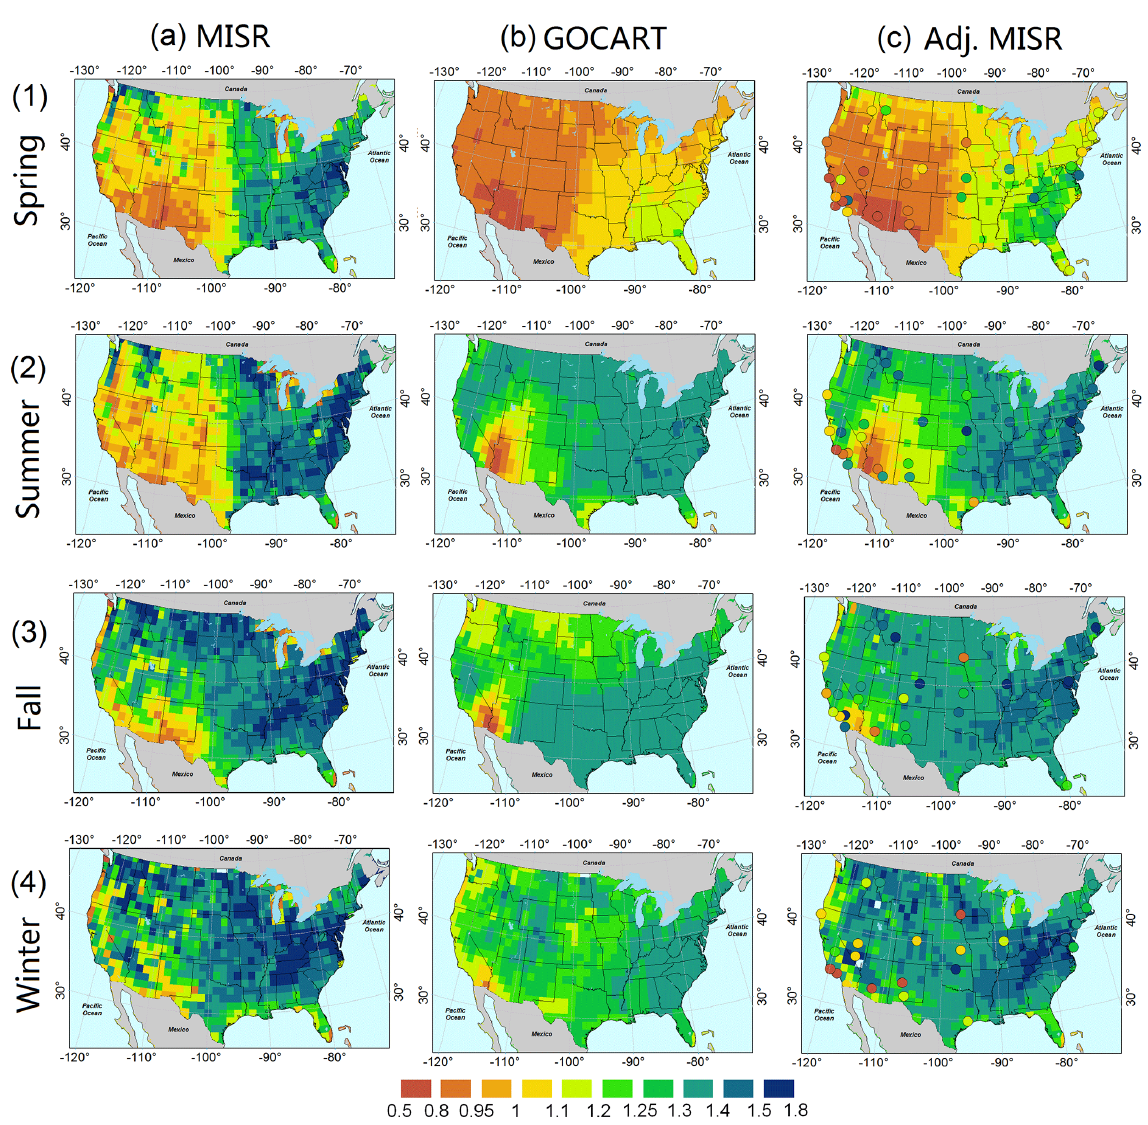
Figure 5. Distributions of seasonally averaged ANG from MISR retrievals (a) , GOCART simulations (b) , this study (c) , and AERONET measurements (superposed as circles in column c) for the years 2006 to 2009, in spring (row 1), summer (row 2), fall (row 3), and winter (row 4). AERONET and GOCART data are temporally and spatially matched to MISR cloud-free